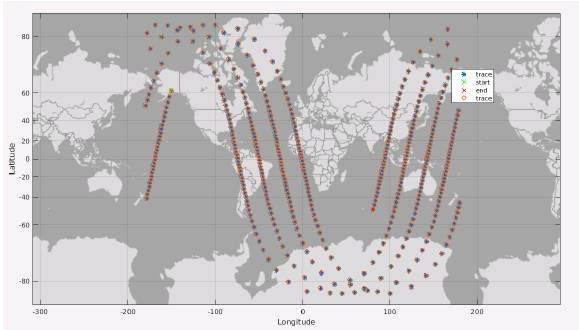
Figure 14. Positioning of the ALOS-2 satellite on both acquisition dates (blue and red)